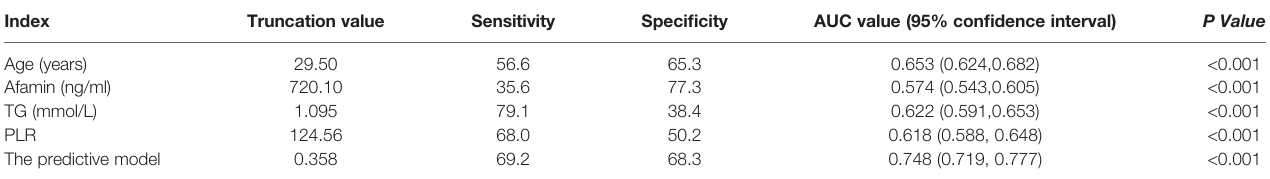
TABLE 3 | Risk factors associated with gestational diabetes mellitus: predictive capabilities.